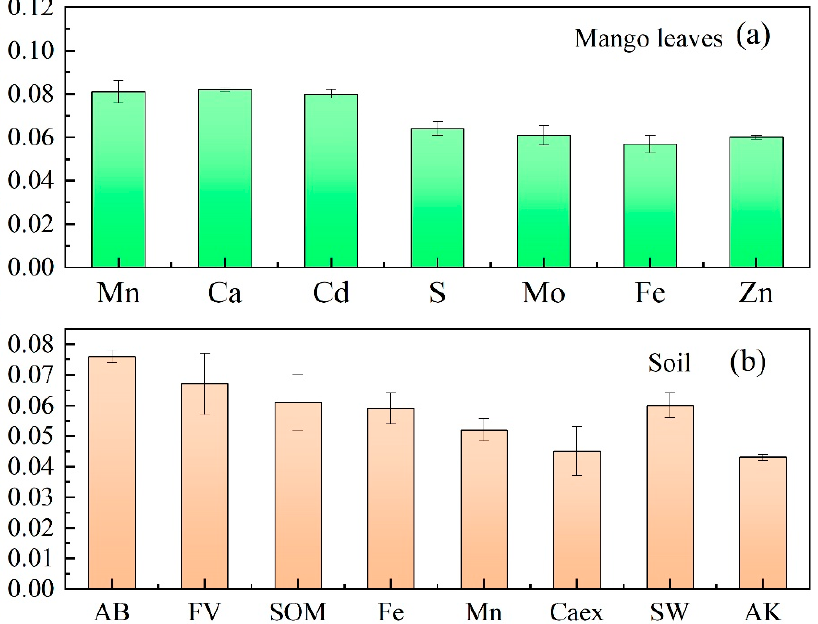
Figure 2. Soil and mango leaf key factor screening. ( a ) Eigenvalues of the key indexes of mango leaves. ( b ) Characteristic values of key indicators of soil indicators.